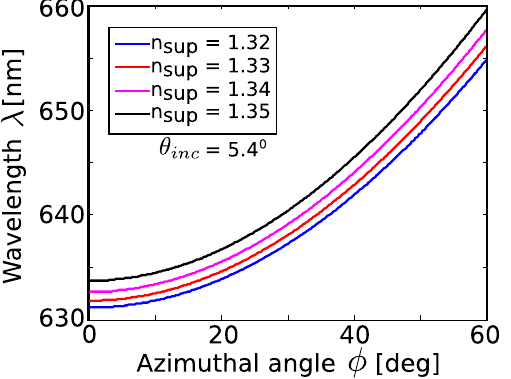
Figure 3. Azimuthal dispersion curves of BSWs for different values of superstrate refractive indices and = 5.4°. θ inc